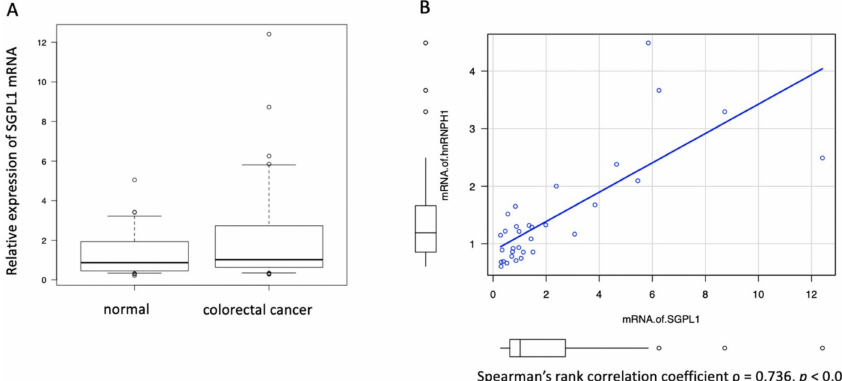
Figure 4. The expression of SGPL1 mRNA and hnRNP H1 mRNA had a strong positive correlation. RT-PCR showed that SGPL1 mRNA tended to be highly expressed in colorectal cancer tissues ( n = 32) compared with normal mucosa tissues ( n = 28, p -Value = 0.01) ( A ) Spearman’s rank correlation revealed a strong positive correlation coe ffi cient between hnRNP H1 mRNA and SGPL1 mRNA. ( B ) * c by Student’s t